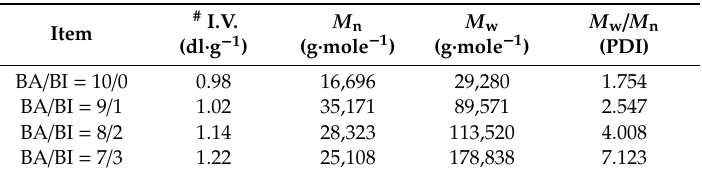
Table 2. Intrinsic viscosity (I.V.), M n , M w , and M w / M n of gel permeation chromatography with